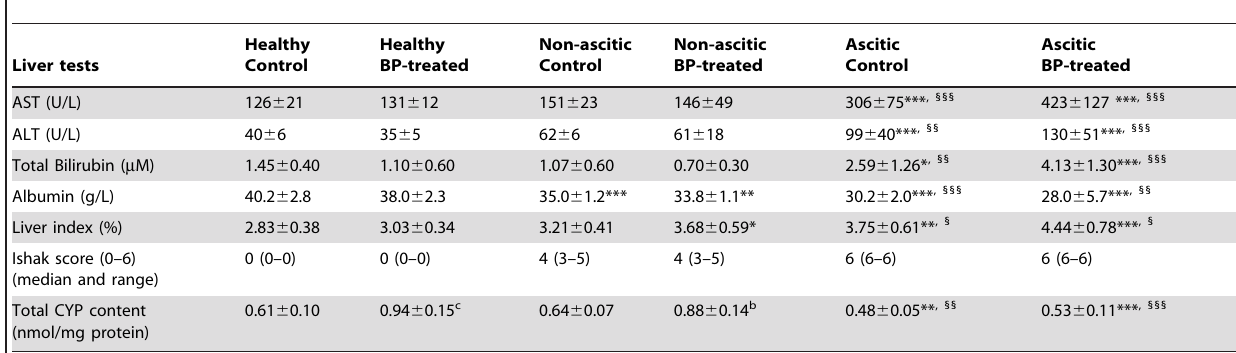
Table 1. Biochemical tests of liver function, histological examination and microsomal total CYP